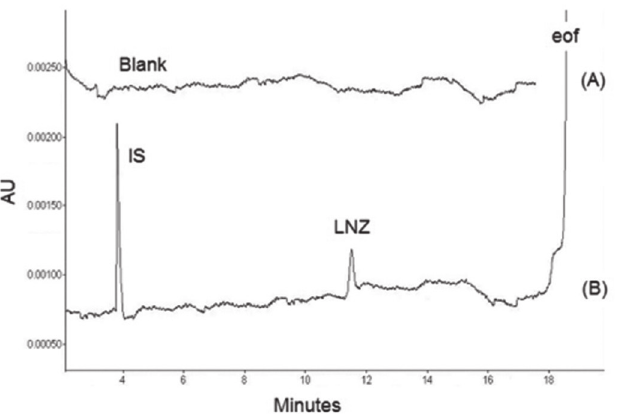
TABLE I - Statistical analysis of calibration graphs and analytical data in the determination of linezolid by electrophoresis method